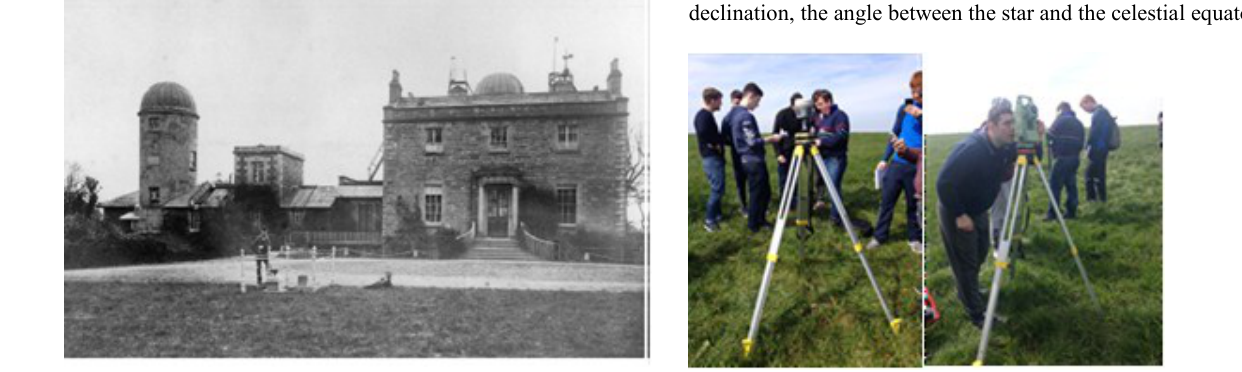
Figure 2: Student Site Survey at the